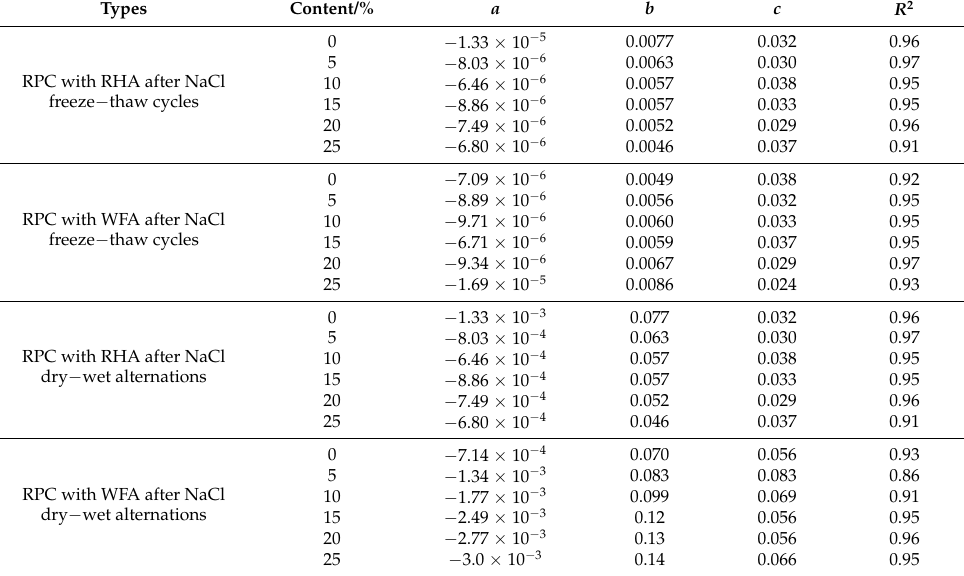
Table 4. The fitting results of mass loss rate.